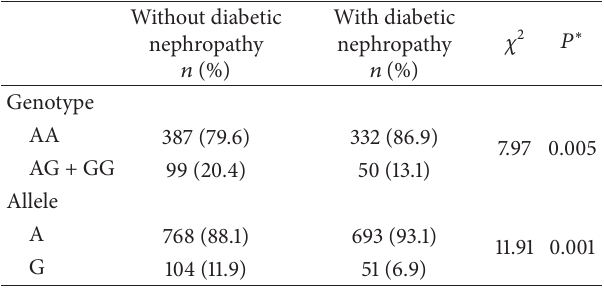
Table 3: The genotypic and allelic distribution of the 2184A/G polymorphism in in type 2 diabetic patients with and without diabetic